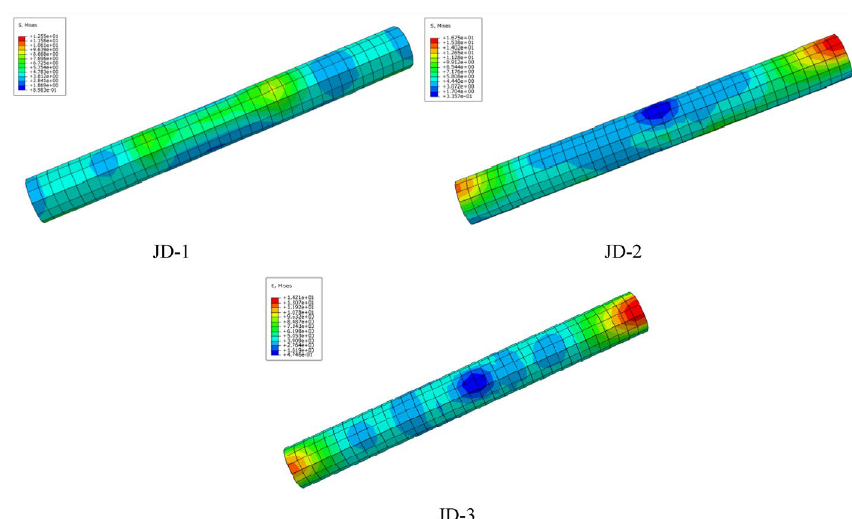
Figure 17. Stress distribution of core concrete